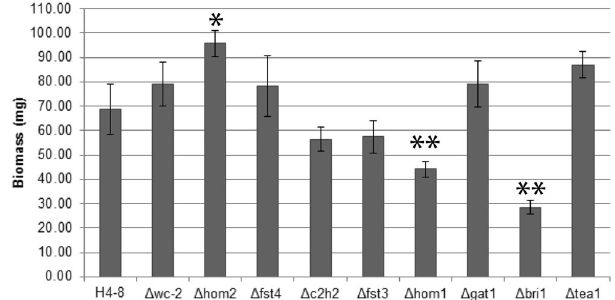
Figure 1. Biomass of biological triplicates of 6-day-old dark-grown agar cultures of the wild-type dikaryon and transcription factor deletion strains using glucose as carbon source. An independent sample t-test (p-value ≤ 0.05) was used to identify strains forming more ( * ) or less ( ** ) biomass when compared to wild-type H4-8 (lines